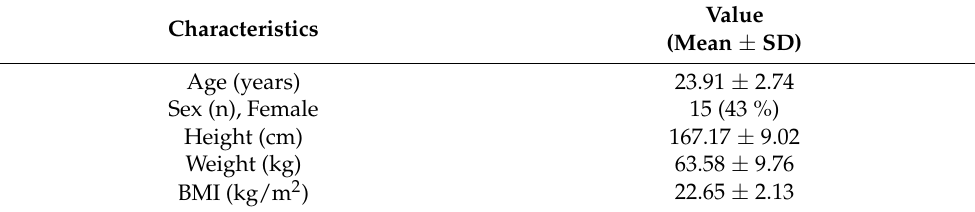
Table 1. General characteristics of the participants ( N = 35).